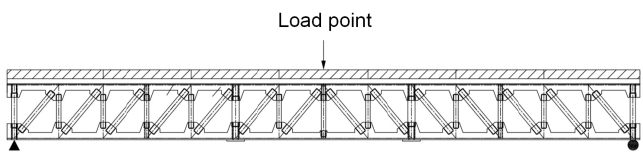
Figure 12. Diagram of test beam’s loading point.